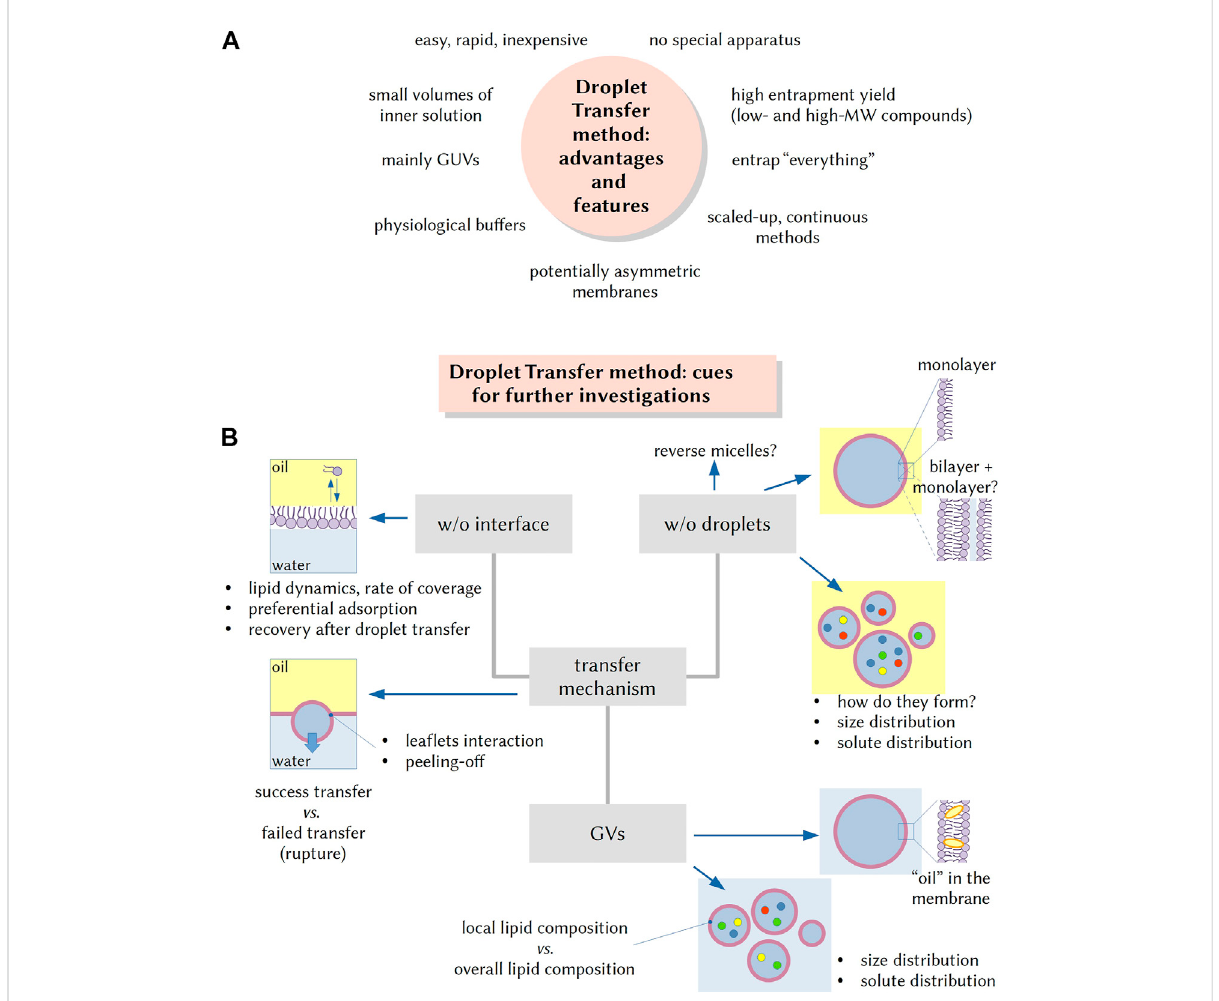
FIGURE 1 Thedroplettransfermethod(DTm):advantageousfeaturesandcuesforfurtherinvestigations. (A) TheadventoftheDTminACresearchisquite attractive as it allows the formation of solute- fi lled GVs in a quite easy and inexpensive manner. Additional advantages are the rapidity (few minutes), no need of speci fi c equipment, employment of small volumes (especially important when complex mixtures need to be encapsulated in the vesicle lumen), the possibility of using physiological buffers, and the possibility of entrapping very large particles. (B) Several experimental steps for carrying out the DTm have been recently investigated and optimized, but open questions remain, and they can be the focus of future investigations. Forexample, itwouldbeimportant to knowmore aboutthelipid dynamicson theoil/water interface, therate ofinterface coverage bylipids andthe recovery of lipids in the “ naked ” area after a w/o droplet has been transfer. What factors affect the fraction of w/o droplets that become GVs? Similarly, the very mechanism of w/o droplet formation ( via stochastic fragmentation and coagulation) is not well known, as well as the factors determining the droplet size and the solute distribution. Other questions can be: are droplets always covered by a lipid monolayer? What is the amountofresidual “ oil ” inthemembraneofresultingGVs?Inthecaseoflipidmixtures,preferentiallocalizationofsomelipidspeciesonallinterfaces (vs those remaining in bulk solution) can occur, and thus, do the obtained GVs have a lipid composition that mirrors the overall lipid composition? Is there any correlation between w/o droplets and GVs size and solute